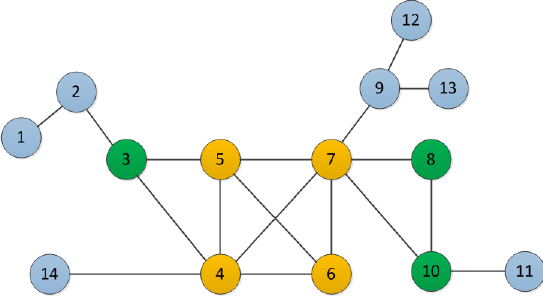
Figure 1. A toy network figure.